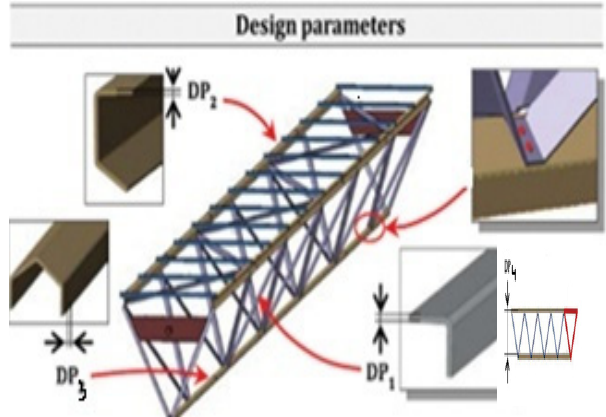
Figure 4. The supporting structure of CSP and the design parameters considered for the truss structure Design parameters ( PC ) were used in the chosen i behavior model in order to estimate the performance